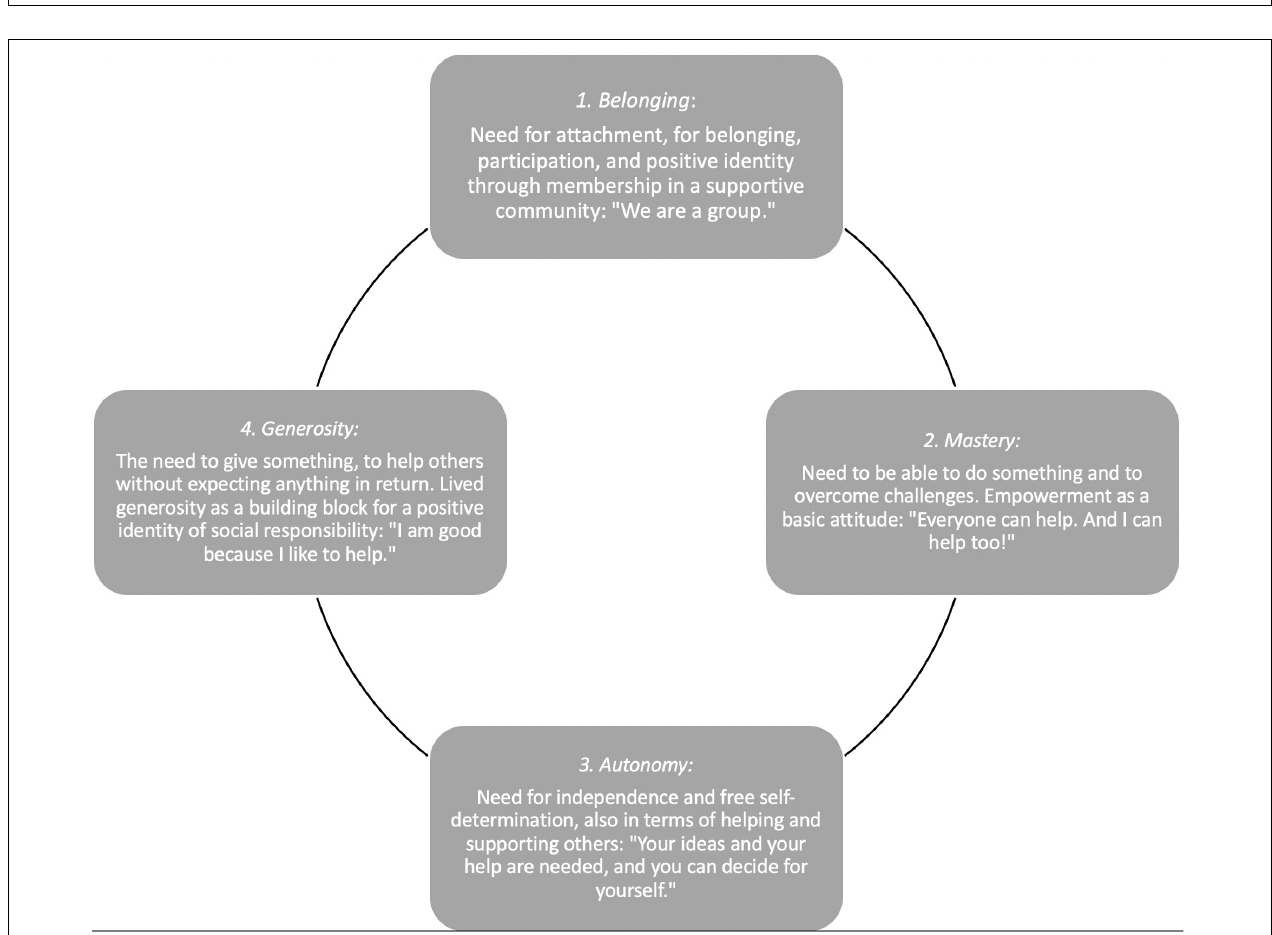
FIGURE 2 | Circle of courage and positive self-development (compare e.g., Steinebach et al., 2018).